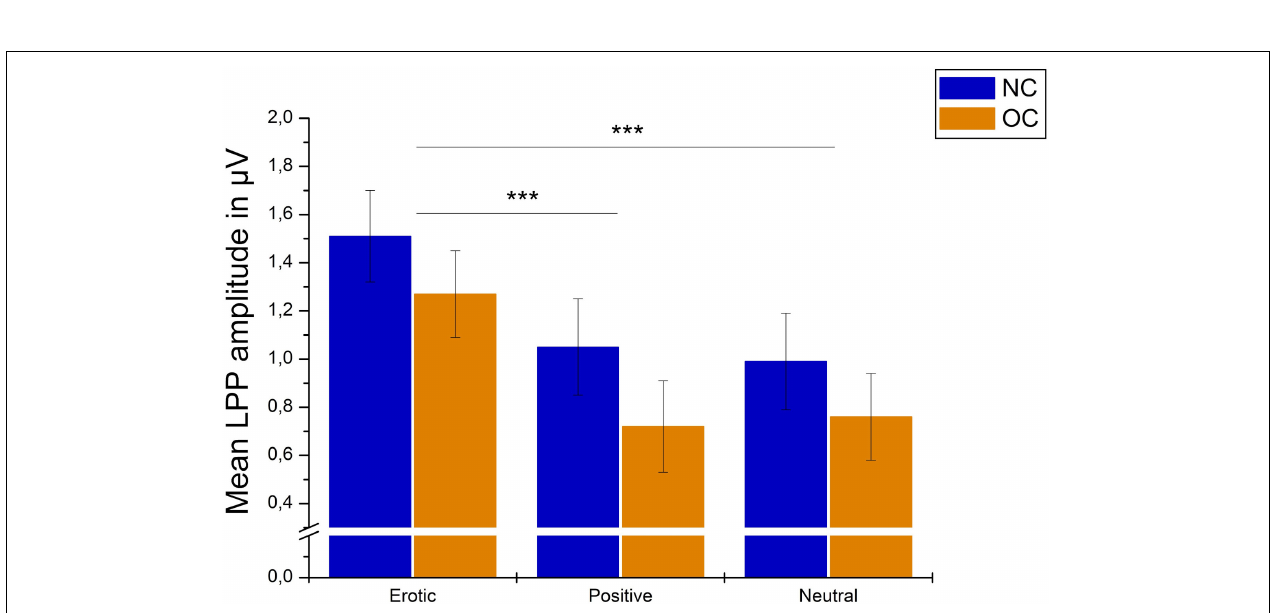
FIGURE 8 | Mean LPP amplitudes in µ V averaged over electrodes CP1, CP2, P1, and P2 in reaction to erotic, positive and neutral stimuli in NC women and OC users. Error bars reflect SEM. *** p < 0.001.